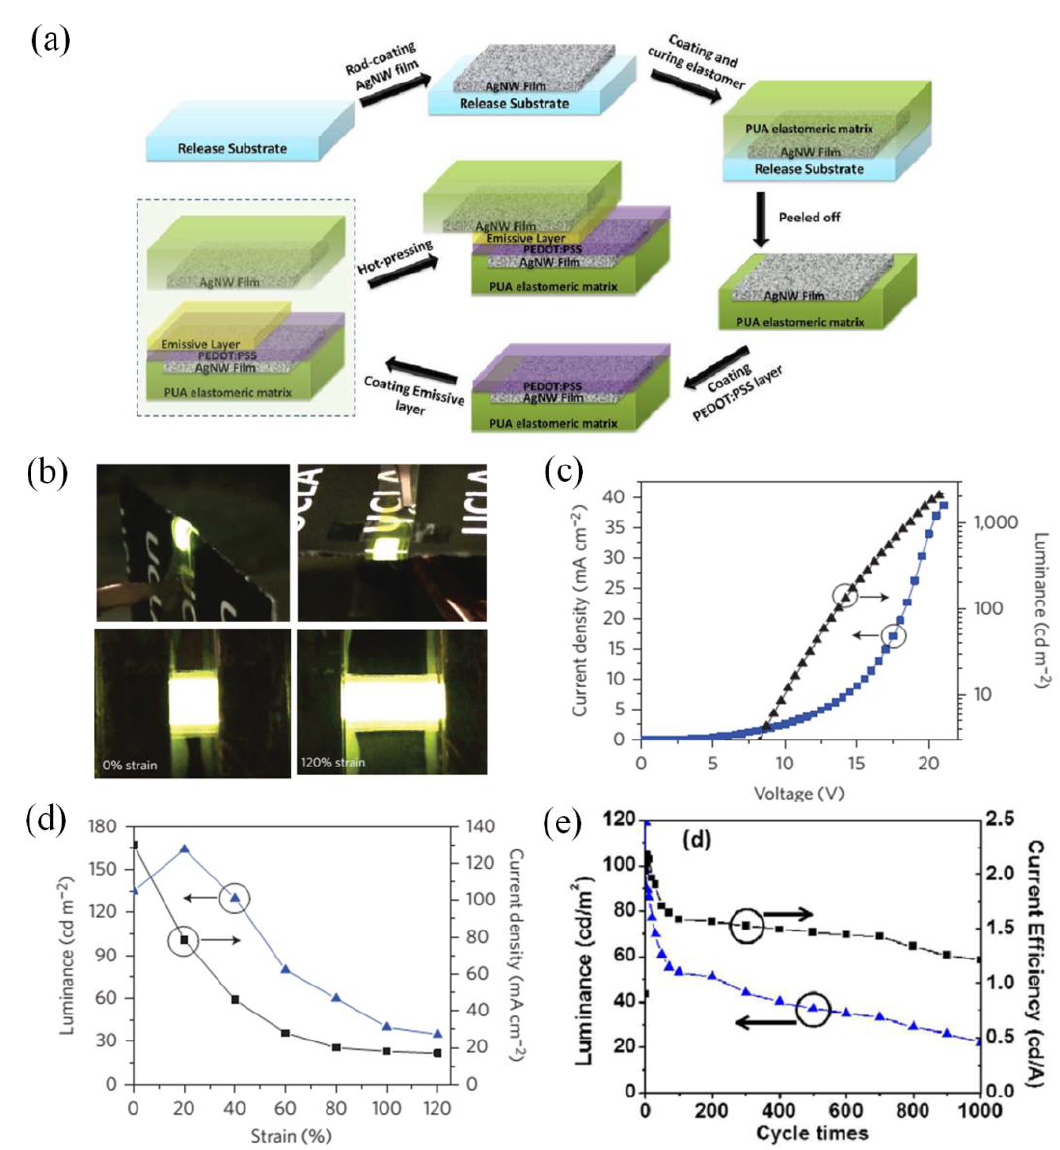
Figure 6: (a) A schematic illustration showing the fabrication process of the stretchable PLECs. (b) Images of a PLEC device wrapped around a cardboard with 400-µm thick and stretched to a maximum strain of 120%. (c) Current density and luminance characteristics of the PLEC under different driving voltages. (d) Change of the luminance and current density of the PLEC with increased strain (biased at 12 V). (e) Mechanical cycling of the PLEC device at 30% strain. Reprinted with permission from Macmillan Publishers Ltd: [Nature Photonics] [18], copyright